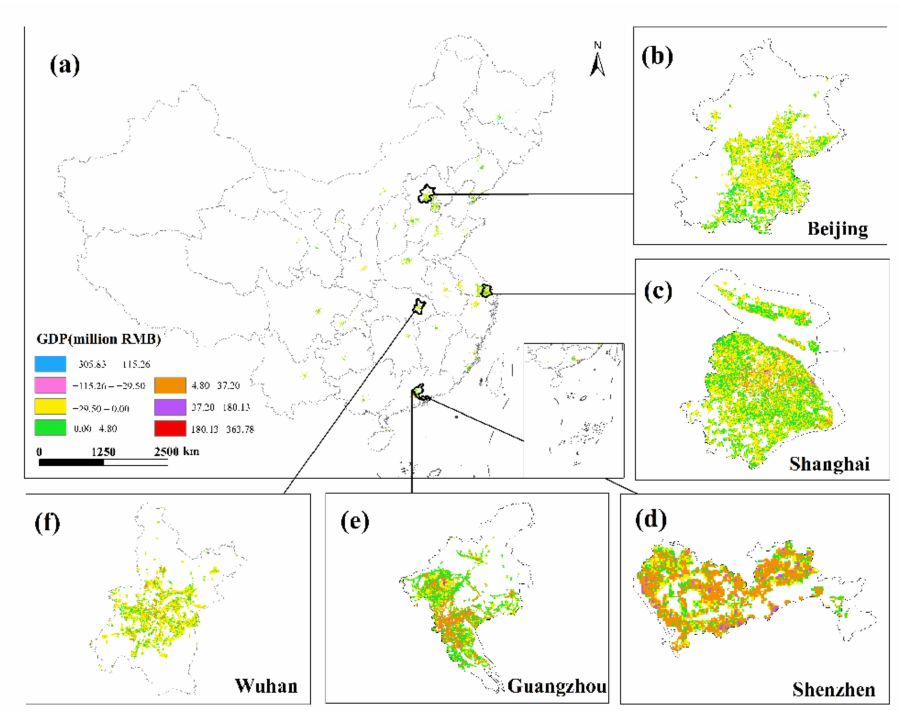
Figure 18. The spatialized result of the sum of GDP in June minus the sum of GDP in May. ( a ) The changes in GDP of 34 cities in China from May to June; ( b ) Beijing; ( c ) Shanghai; ( d ) Shenzhen; ( e ) Guangzhou; ( f )